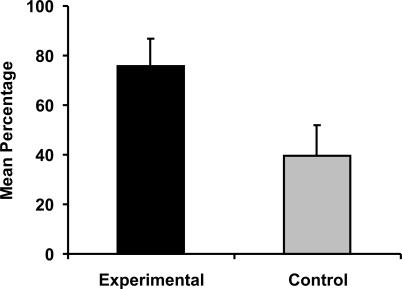
Experiment 3Mean percentage of trials with target behavior (releasing the target chain) by condition. Error bars represent SEM. Each subject was tested in both conditions in a within-subject comparison.